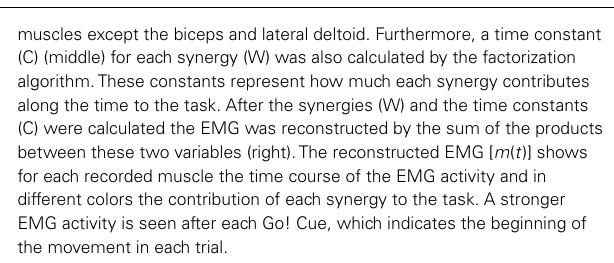
FIGURE 3 | Cluster analysis for all patients ( N = 33) .The silhouette value for the (A) paralyzed and (B) healthy upper limb was calculated.The dashed line represents the optimal number of clusters, which were extracted and plotted for the paralyzed (C) and healthy (D) upper limbs. Each cluster is represented by the normalized contribution (mean ± SD) (from 0 to 1, where 1 is the maximum contribution) of each recorded muscle across patients (green bars): (1) extensor carpi ulnaris (Ext. Carpi), (2) extensor digitorum (Ext. Dig.),